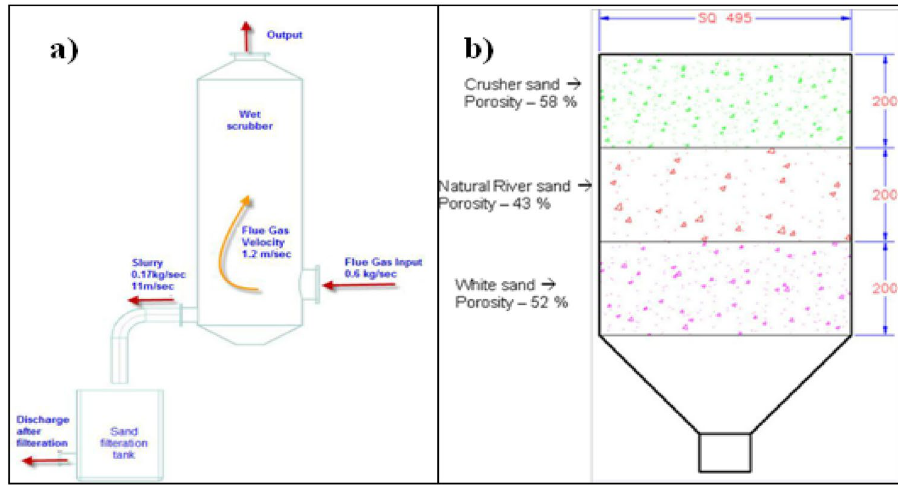
Figure 1. ( a ) Wet scrubber and sand flirtation setup, ( b ) multi filtration zones (porosity and zone